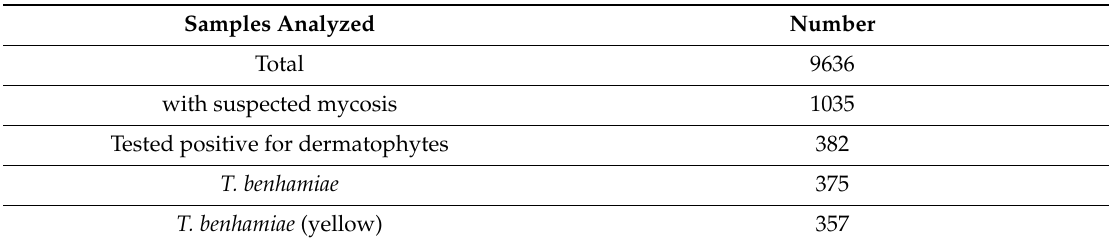
Table 4. Detection of dermatophytes in guinea pig samples from SYNLAB VET and LABOKLIN, February–November